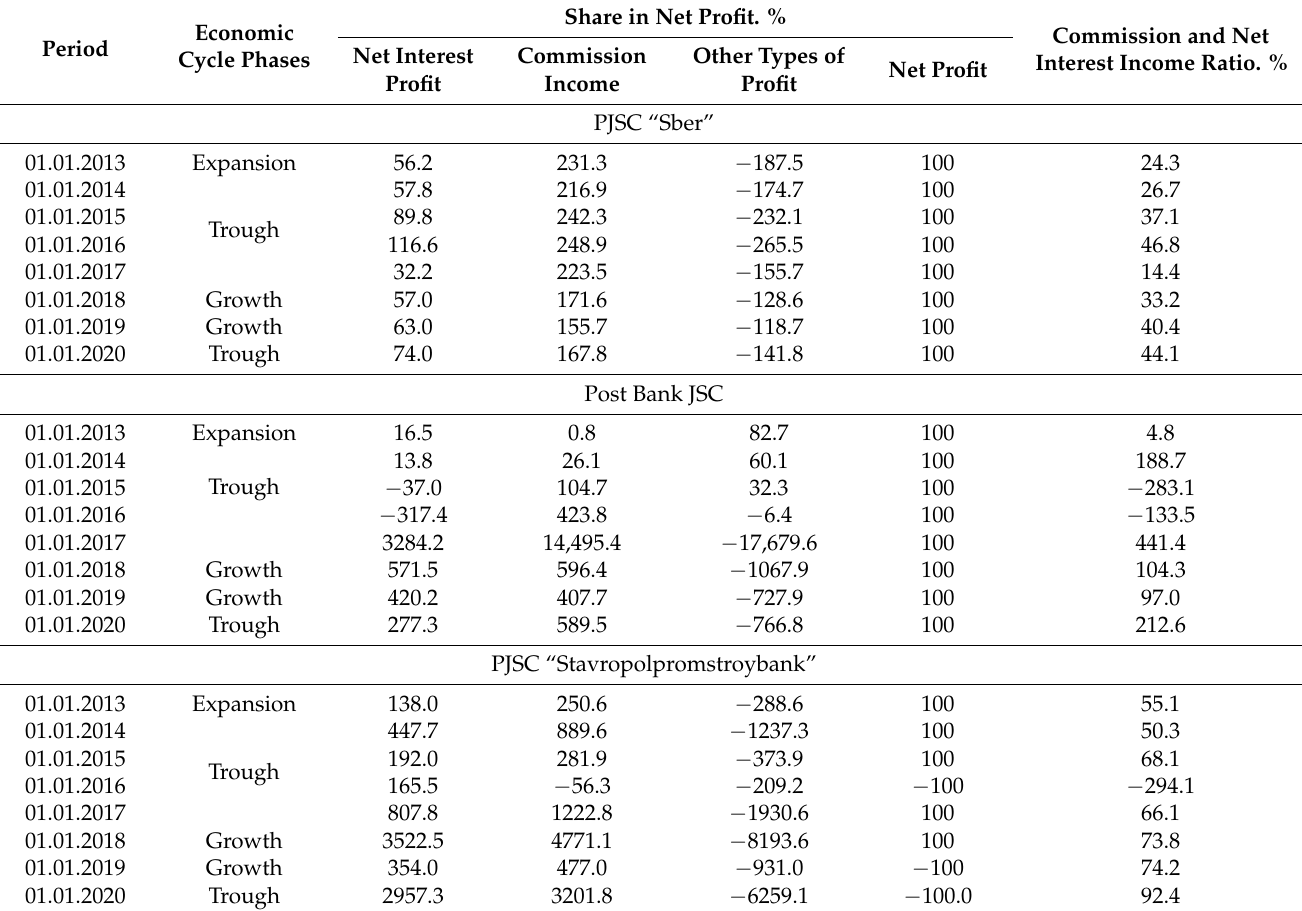
Table 2. Assessment of potential financial performance of financial and innovative strategies in selected commercial banks. Economic Period Cycle Phases